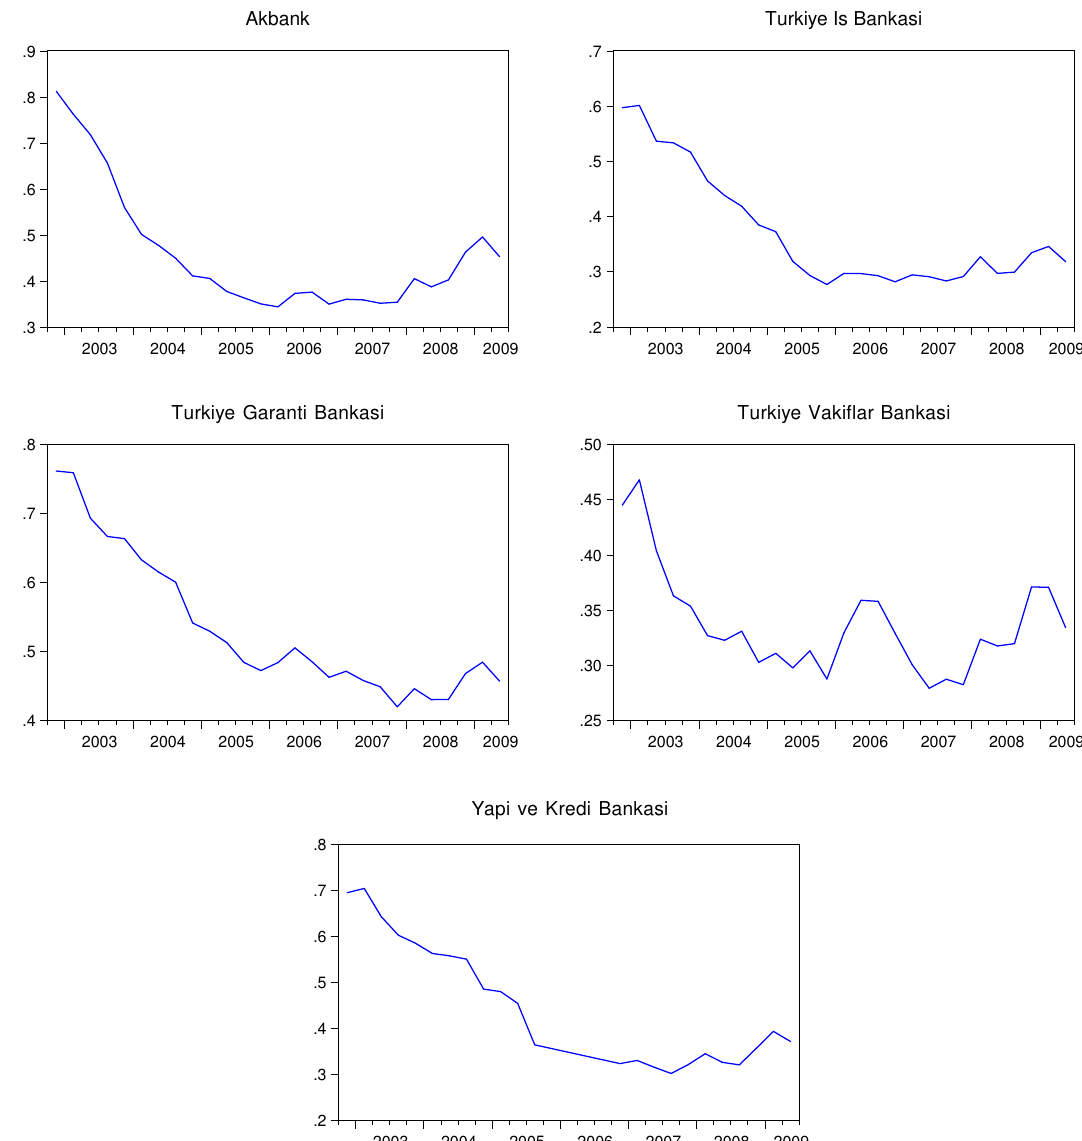
Figure 2. FC loans to total loan portfolio for the largest non-state